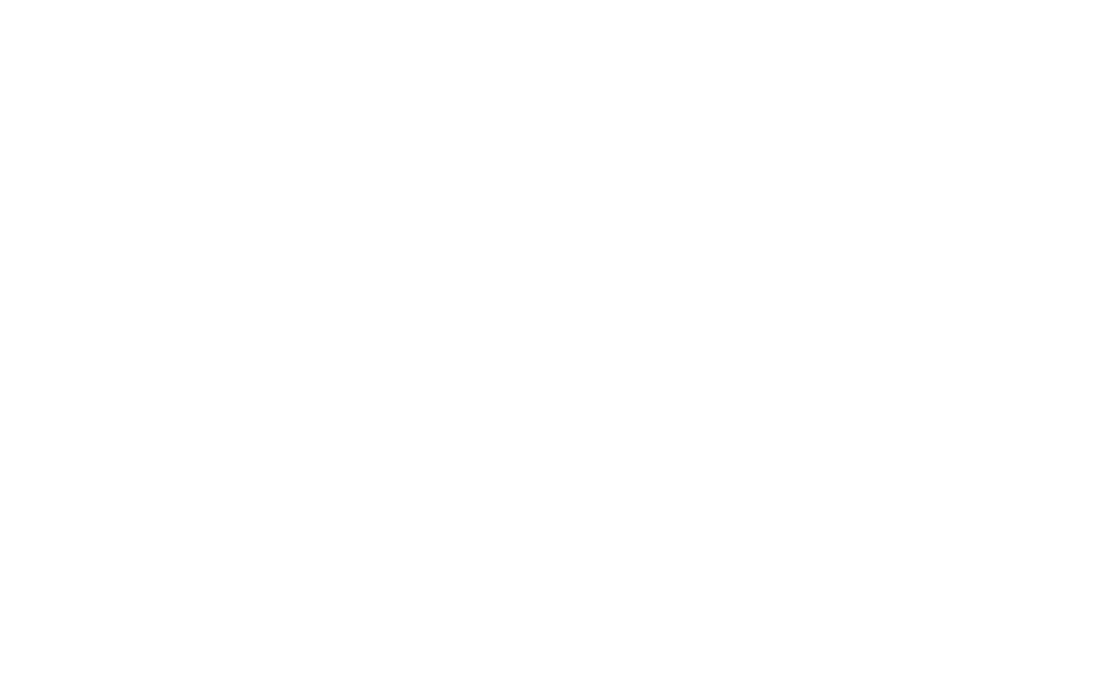
Figure 8. ( a–c ) Dependence of N 0 on centrality and ( d ) Dependence of N 0 on m 0 , for d , ¯ 3 He ( 3 He + )/ 2 in Au–Au, Pb–Pb, p–Pb and p–p